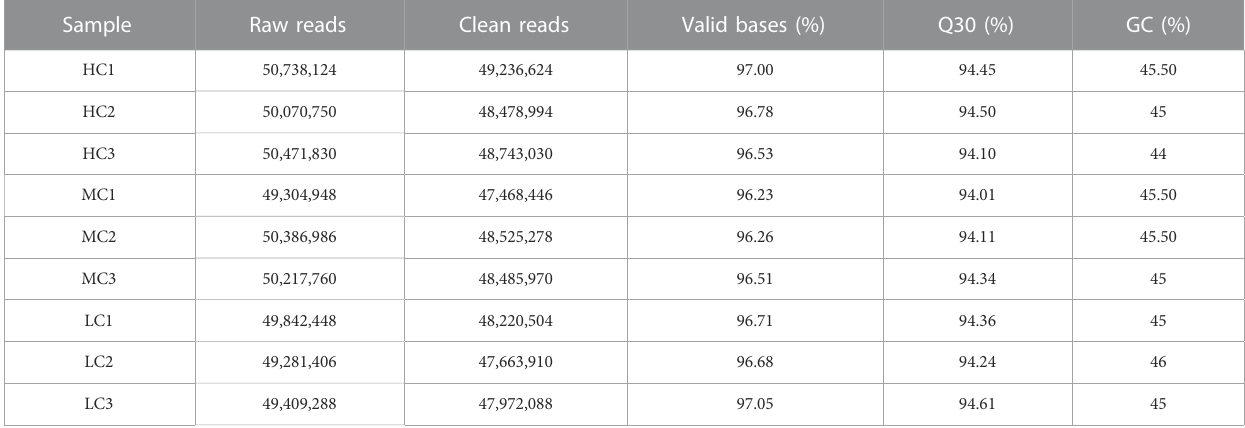
TABLE 1 Overview of the sequencing results. Sample